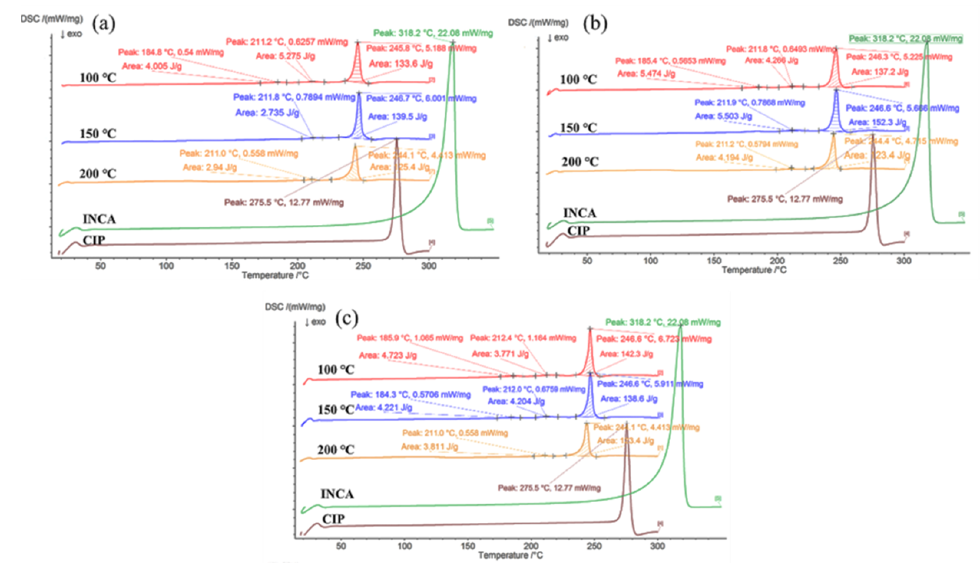
Figure 9. DSC thermograms of extrudates prepared at various temperature and screw speed using conveying screw configuration ( a ) 10 rpm, ( b ) 55 rpm, and ( c ) 100 rpm.